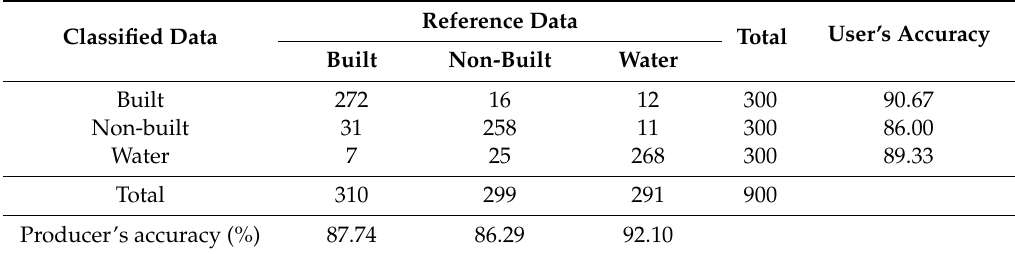
Table A1. Error matrix for the classified 1992 land use/cover map.